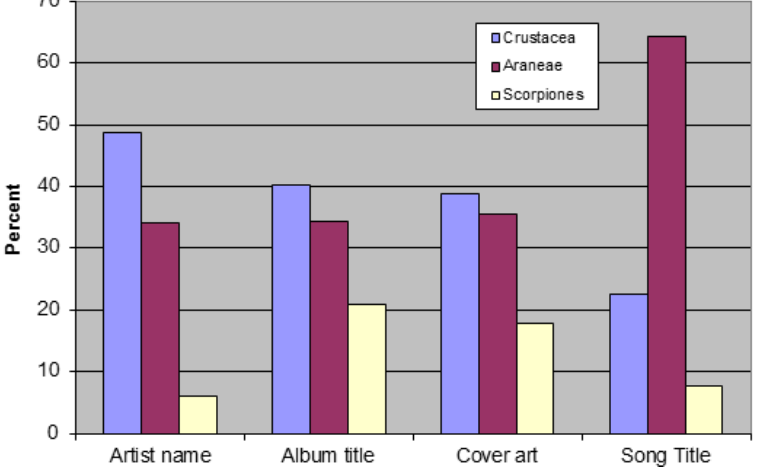
Figure 1. Simplified taxonomic summary of noninsect arthropods in popular